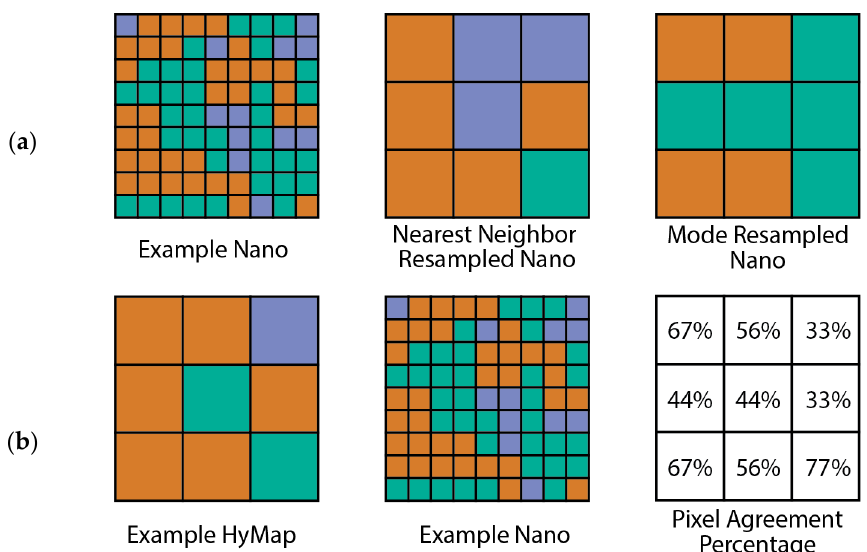
Figure 4. Pixel Based Map comparison concepts with three classes. ( a ) Nearest neighbor and mode resampling examples. ( b ) Pixel agreement percentage. Note: Not to scale.